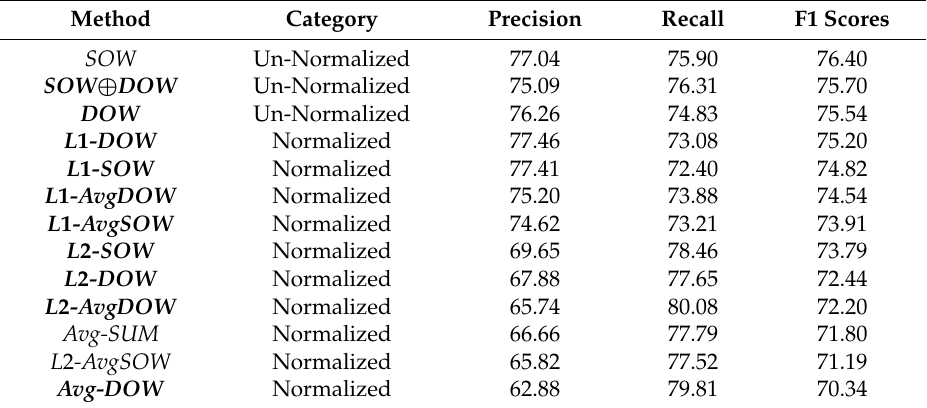
Table 9. Results summary of aspect category detection in SemEval-2016 dataset.